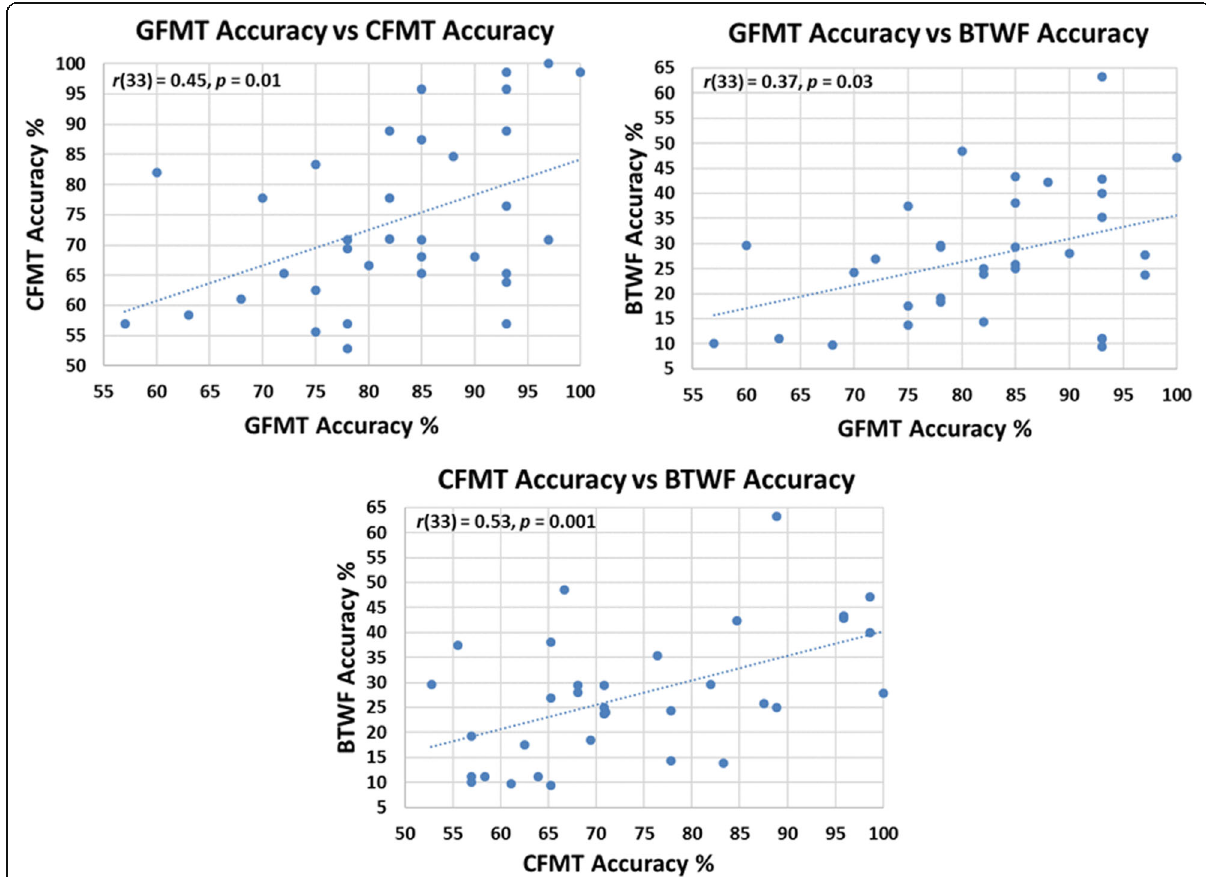
Fig. 1 Scatterplots showing the correlations between performance on the Glasgow Face Matching Test (GFMT) and the Cambridge Face Memory Test (CFMT) (upper left), the GFMT and the Before They Were Famous (BTWF) task (upper right), and the CFMT and BTWF (lower) in Study